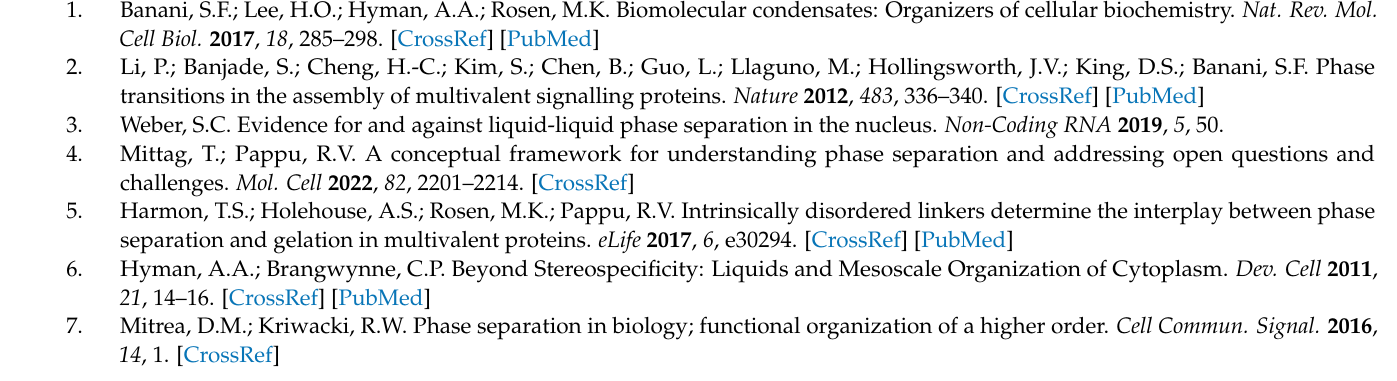
Table S11. Uniprot IDs of 6812 sequences from PDB + human base. File S1. 565 PS-positive se- quences (fasta file). File S2. Hierarchical clustering dendrogram of PS-positive sequences (pdf